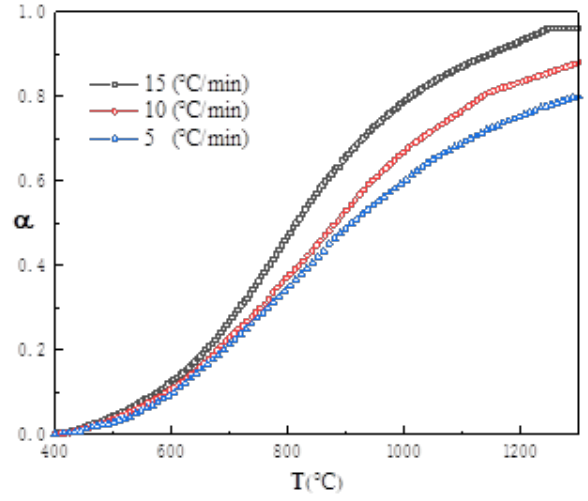
Figure 5. Non- isothermal “α vs. T” graphs for iron ore at different heating rates.